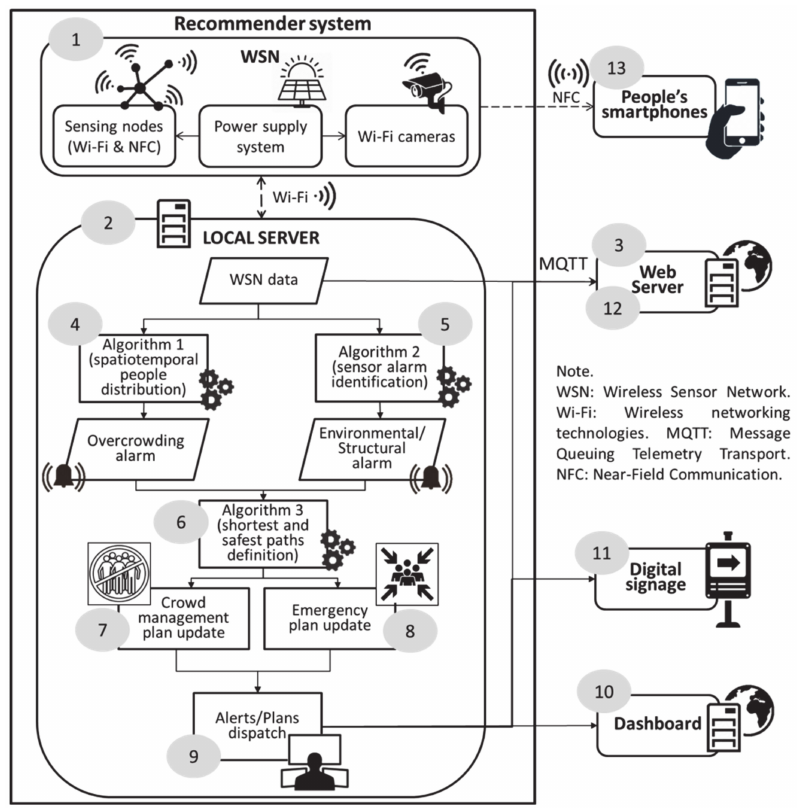
Figure 3. Framework of the proposed IoT system.